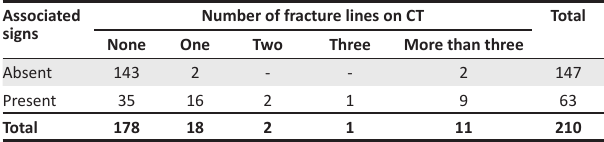
Type of petrous bone fracture